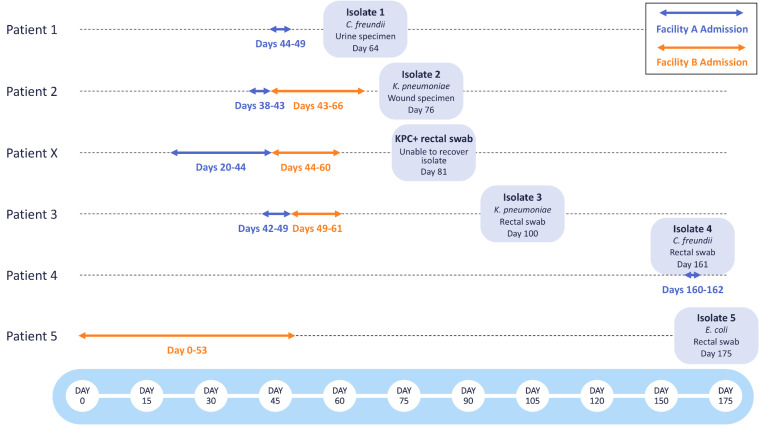
Timeline of KPC-producing bacterial isolates collected during epidemiological investigations at Facilities A and B. The admission dates of Patients 1-5 and Patient X at Facility A (blue) and Facility B (orange) are shown as arrows. The bacterial species, specimen type, and date of specimen collection are shown for each bacterial isolate.